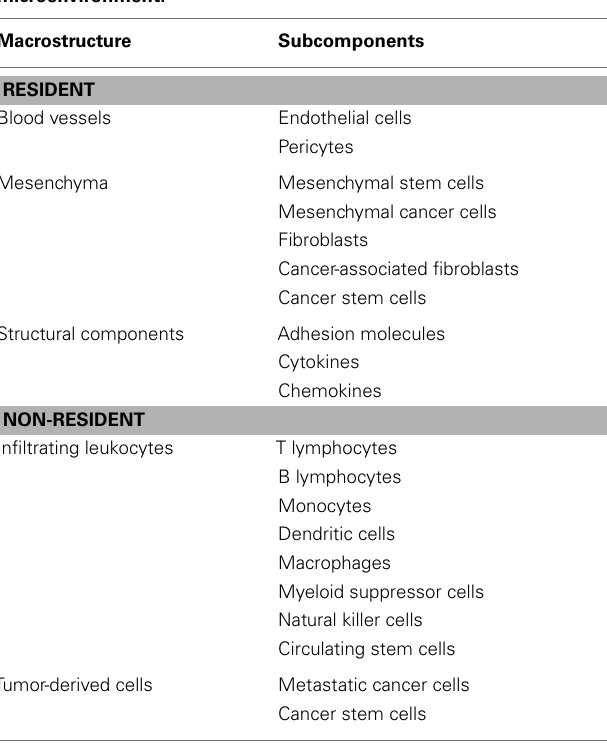
Table 1 | Main structural and cellular components of the tumor microenvironment.